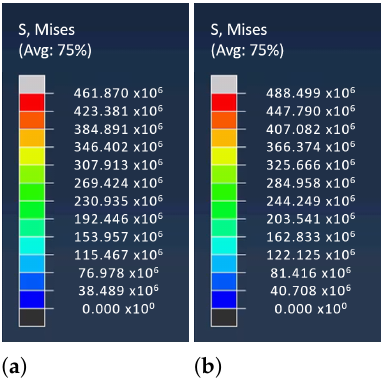
Figure 6. Stress Colormap Scale: ( a ) Traditional Lagrangian Model, ( b ) Mixed Traditional-SPH Model.